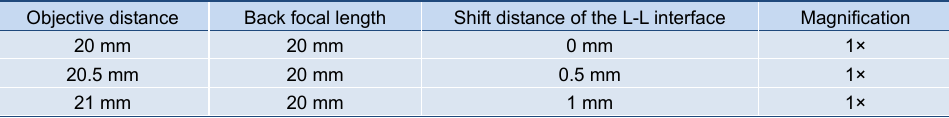
Fig. 4 | ( a ) Simulation of the movable electrowetting optofluidic lens. ( b ) MTF for 20 mm object distance. ( c ) MTF for 20.5 mm object distance. ( d ) MTF for 21 mm object distance. Table 1 | Parameter of the device in simulation for axial